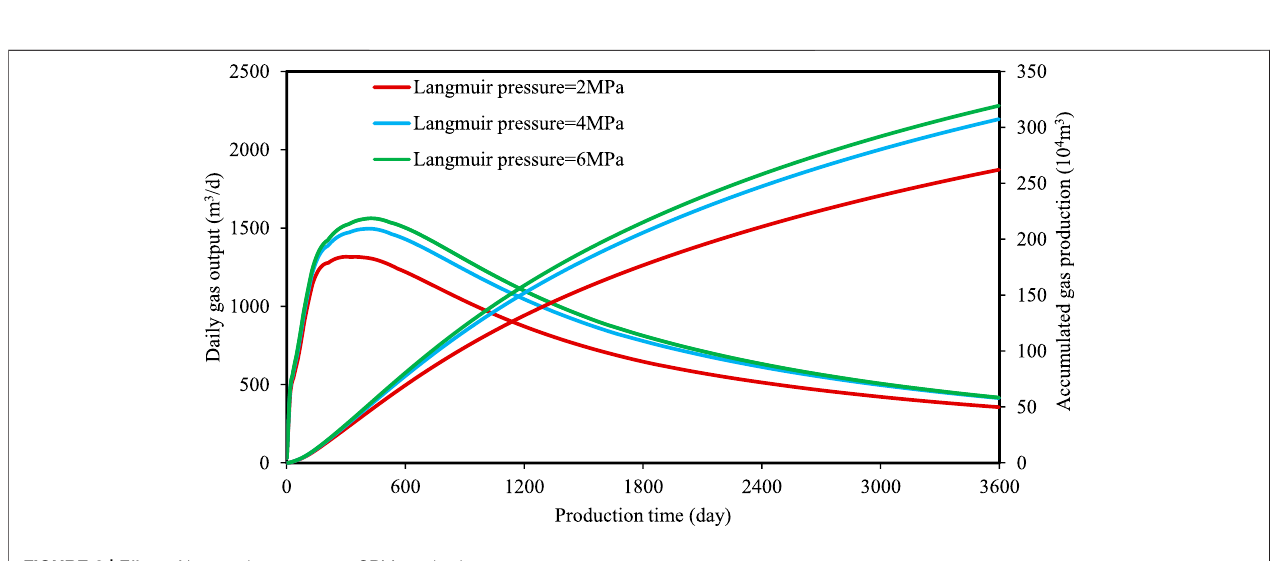
FIGURE 8 | Effect of Langmuir pressure on CBM